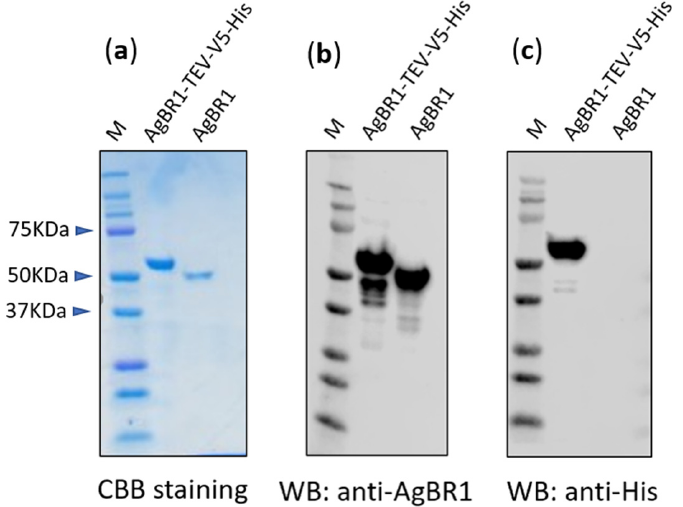
Figure 1. Expression of recombinant AgBR1 protein and polyhistidine-tag cleavage. Recombinant AgBR1 protein was expressed using stable transfected S2 cells, and the polyhistidine tag was cleaved by TEV protease. ( a ) Analysis of purified recombinant AgBR1-TEV-V5-His and His-cleaved AgBR1 protein by SDS-PAGE stained with Coomassie Brilliant Blue (CBB). ( b ) Analysis of AgBR1 His-cleaved recognition by rabbit anti-AgBR1 specific antibodies by Western Blotting. ( c ) Analysis of His-cleavage efficacy by Western Blotting using an anti-His tag specific antibody.